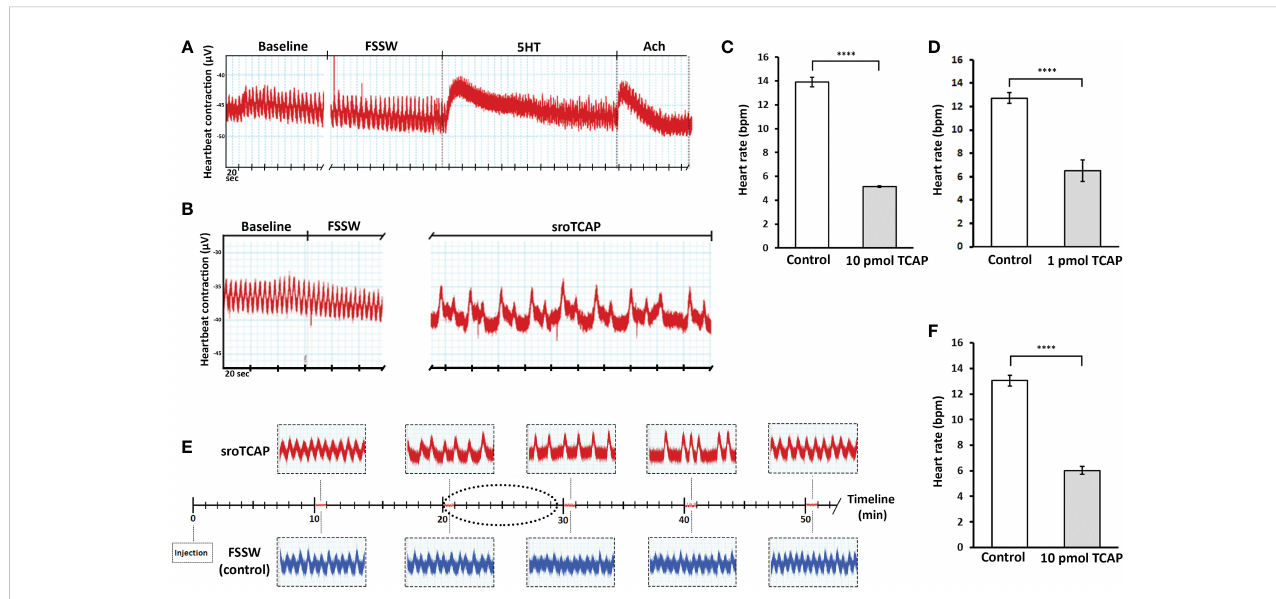
FIGURE 5 SRO heart rate following pericardial and IM administration of sroTCAP, FSSW and neurotransmitters. (A) Representative trace showing baseline heart rate following FSSW, 10 mM serotonin (5-HT) and 10 mM acetylcholine (ACh). (B) Representative trace showing baseline heart rate following FSSW and 10 pmol sroTCAP. (C) Histogram showing the frequency change in oyster heart rate (beats per min; BPM) in response to FSSW (control) and 10 pmol sroTCAP (n=3). (D) Histogram showing the frequency change in oyster heart rate (BPM) in response to FSSW (control) (n=3) and 1 pmol sroTCAP (n=4). (E) Heart rate comparison between TCAP and FSSW injected oysters showing 1 min timeline of heart rate traces at different time-points post-TCAP injection IM (red) and FSSW injection IM (blue). The dotted ellipse shows the region of data sampling. (F) Histogram showing the frequency change of BPM in FSSW control and TCAP IM-injected groups (n=4), (**** P < 0.0001).